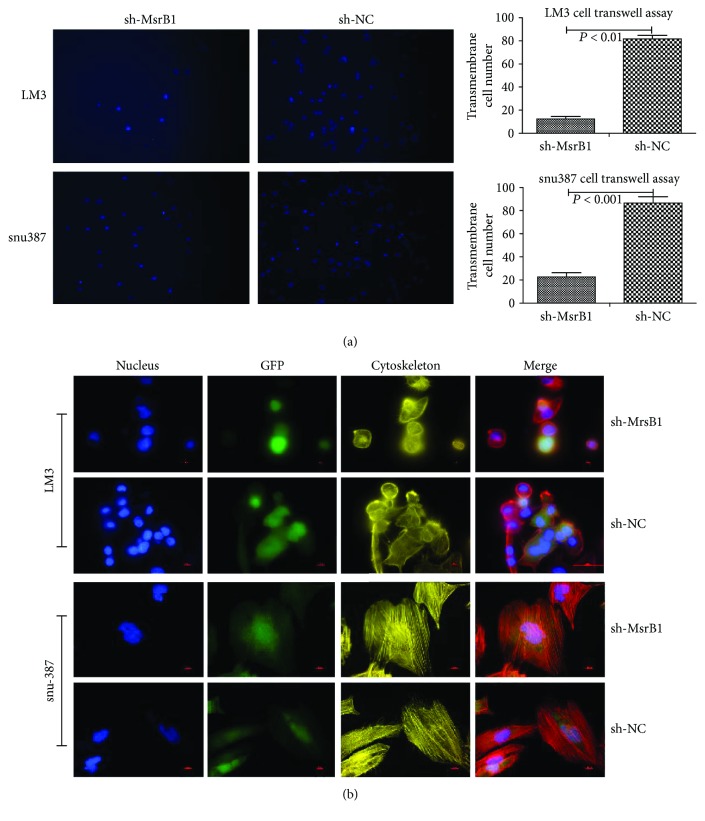
MsrB1 knockdown inhibited the migration of HCC cells. (a) The transwell assay demonstrated that knockdown of MsrB1 reduced the migration of HCC cells. (b) Knockdown of MsrB1 leads to cytoskeletal rearrangement and inhibition of cell adhesion and spreading of HCC cells.